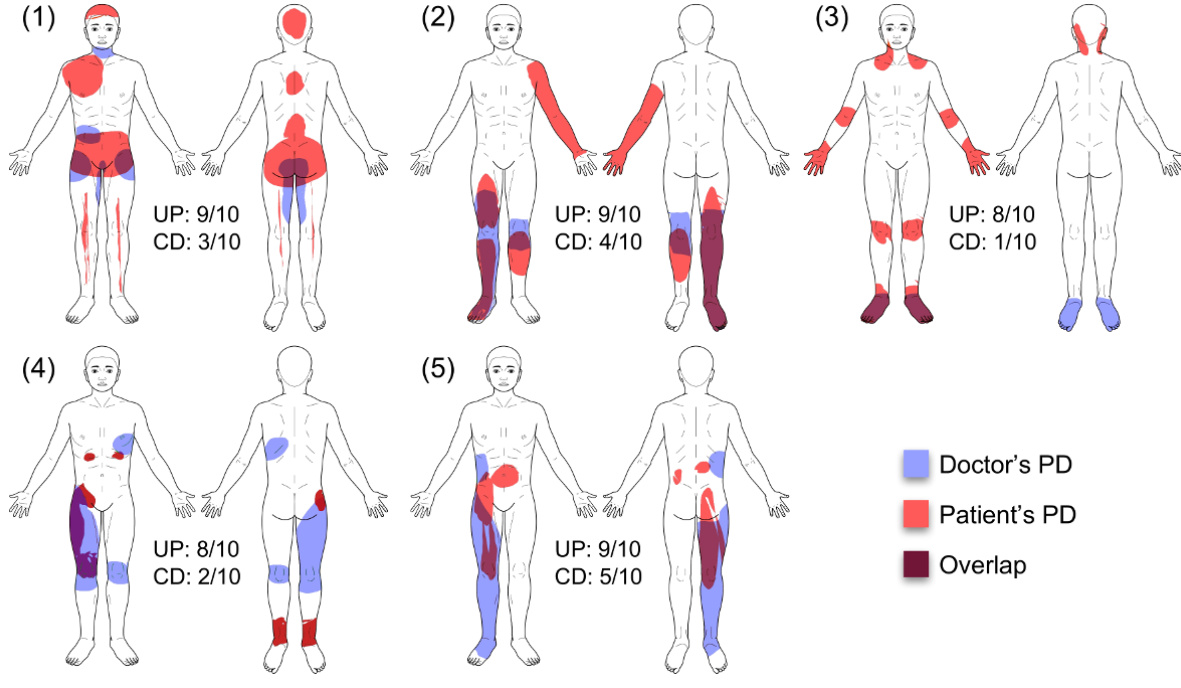
Figure 4. A comparison of patients’and doctors’pain drawings (PDs) for individual patients, in which knowledge of the PD led to strong improvement of the doctor’s understanding of the patient. CD: impact on clinical decision; UP: understanding of the